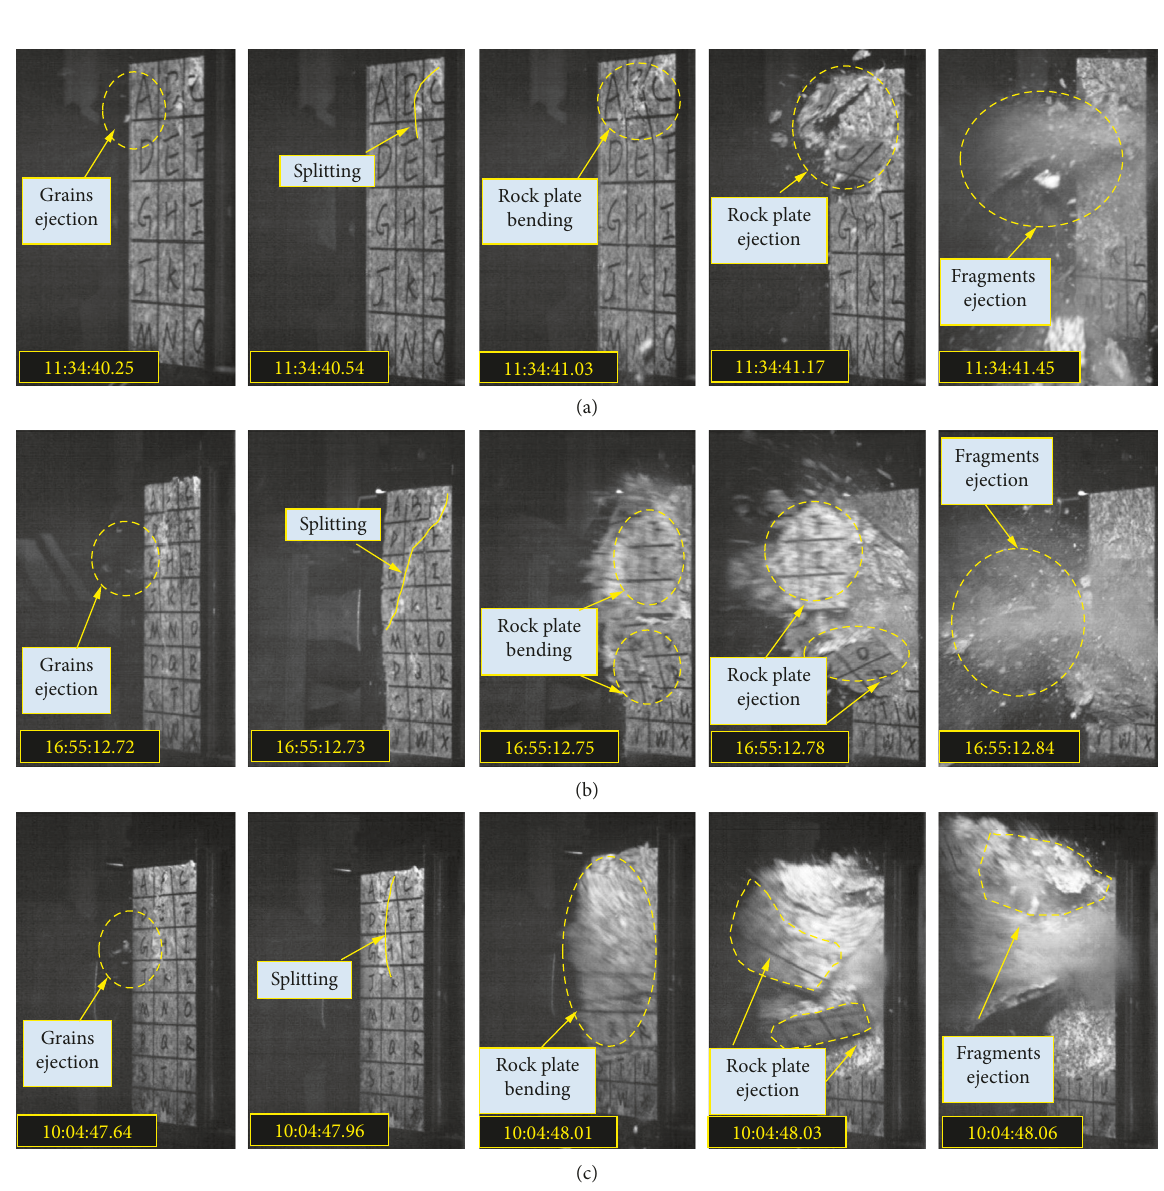
Figure 14: The rockburst process of the tested specimens under different support failure timings (the numbers at the bottom-left corner of the pictures indicate the time in h:m:s.ms): (a) σ 1 / σ max